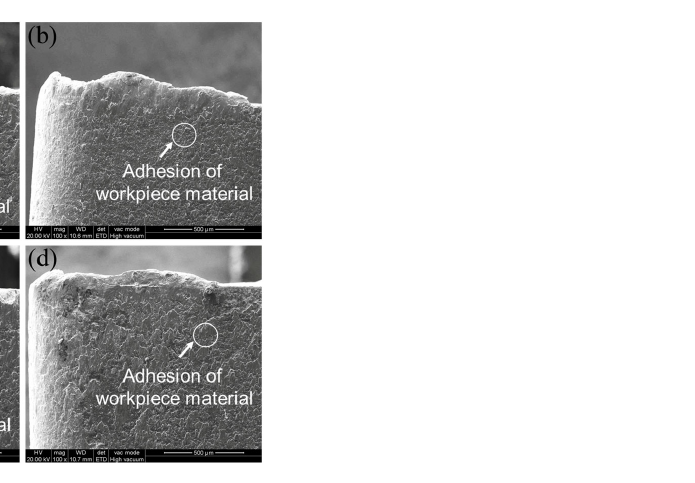
Figure 14. Wear of the flank face using CCI: ( a ) CT; ( b ) 0.42 A/mm 2 ; ( c ) 0.57 A/mm 2 ; and ( d ) 0.90 A/mm 2 . Table 5. EDS analysis of A, B, C, and D.